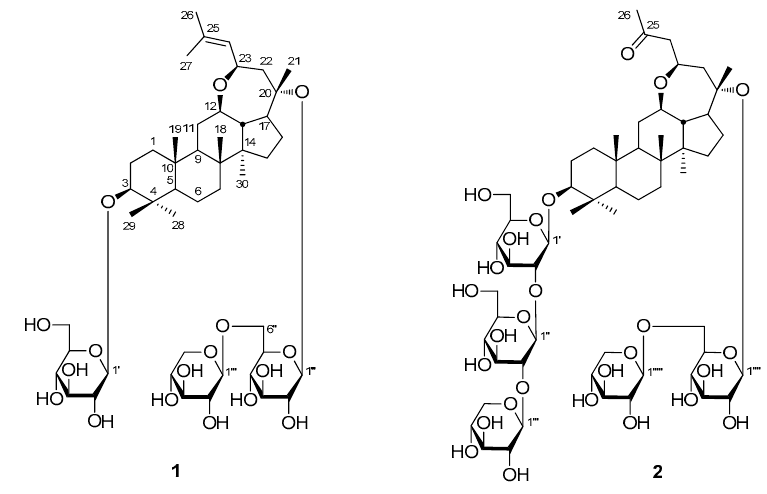
Figure 1. The structures of compounds ( 1 ) and ( 2 ).